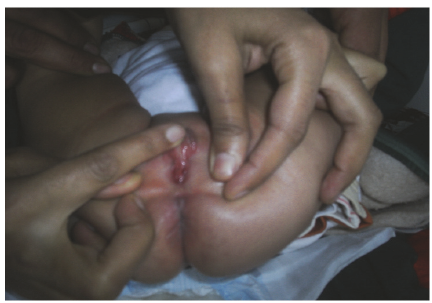
Figure 1: Appearance of the external genitalia.